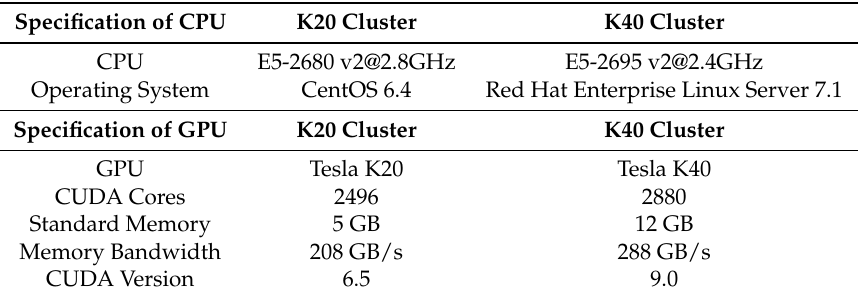
Table 1. Configurations of GPU